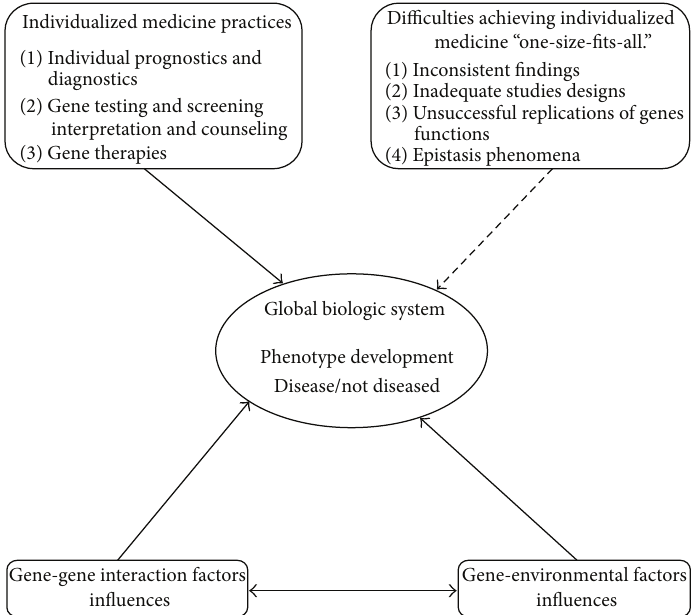
Figure2:Schemaillustratingpersonalizedmedicineconceptanditsdifficulties. Note. Dashedlinesindicatedifficultiesachievingpersonalized medicine. The figure is the illustration of classic “one-size-fits-all” pharmacological therapies to individualized treatment which takes to account the individual genotype